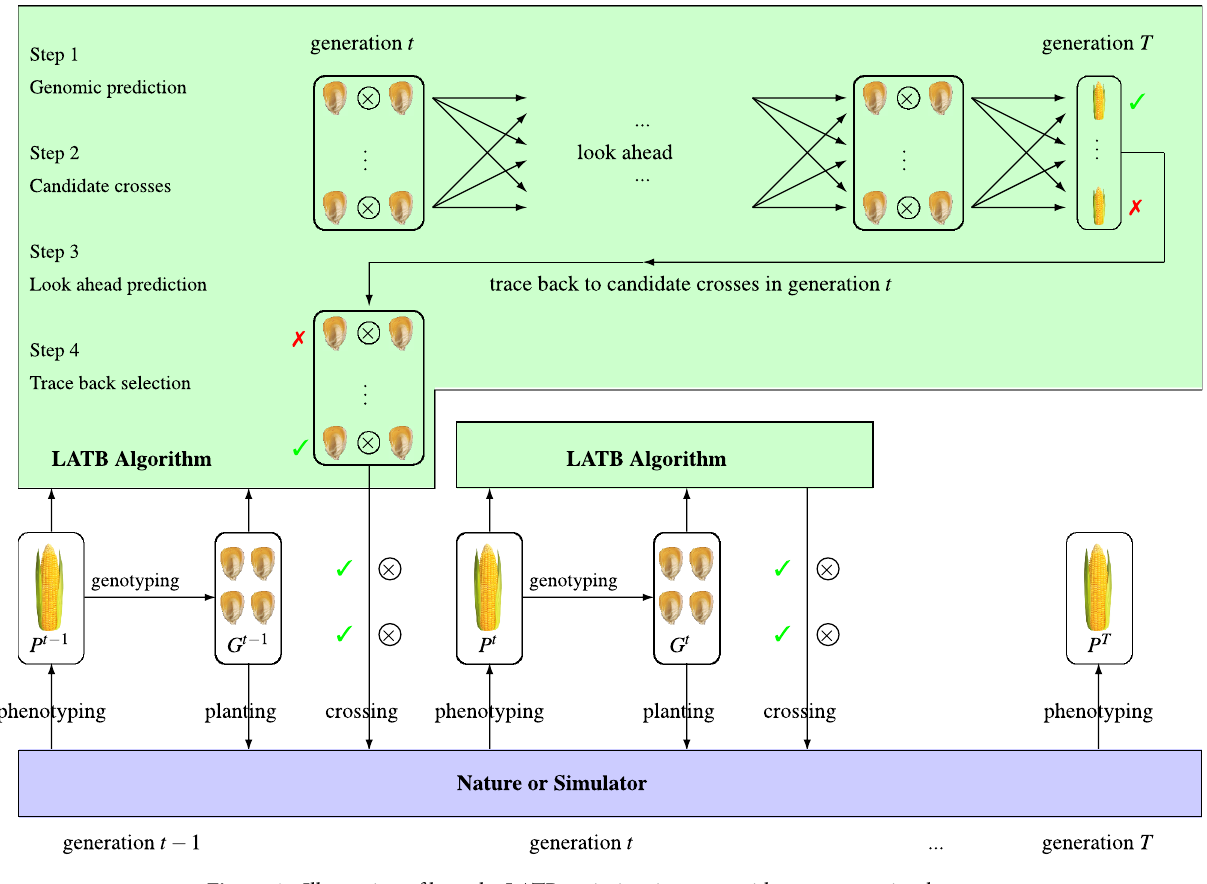
Figure 4. Illustration of how the LATB optimizer interacts with nature or a